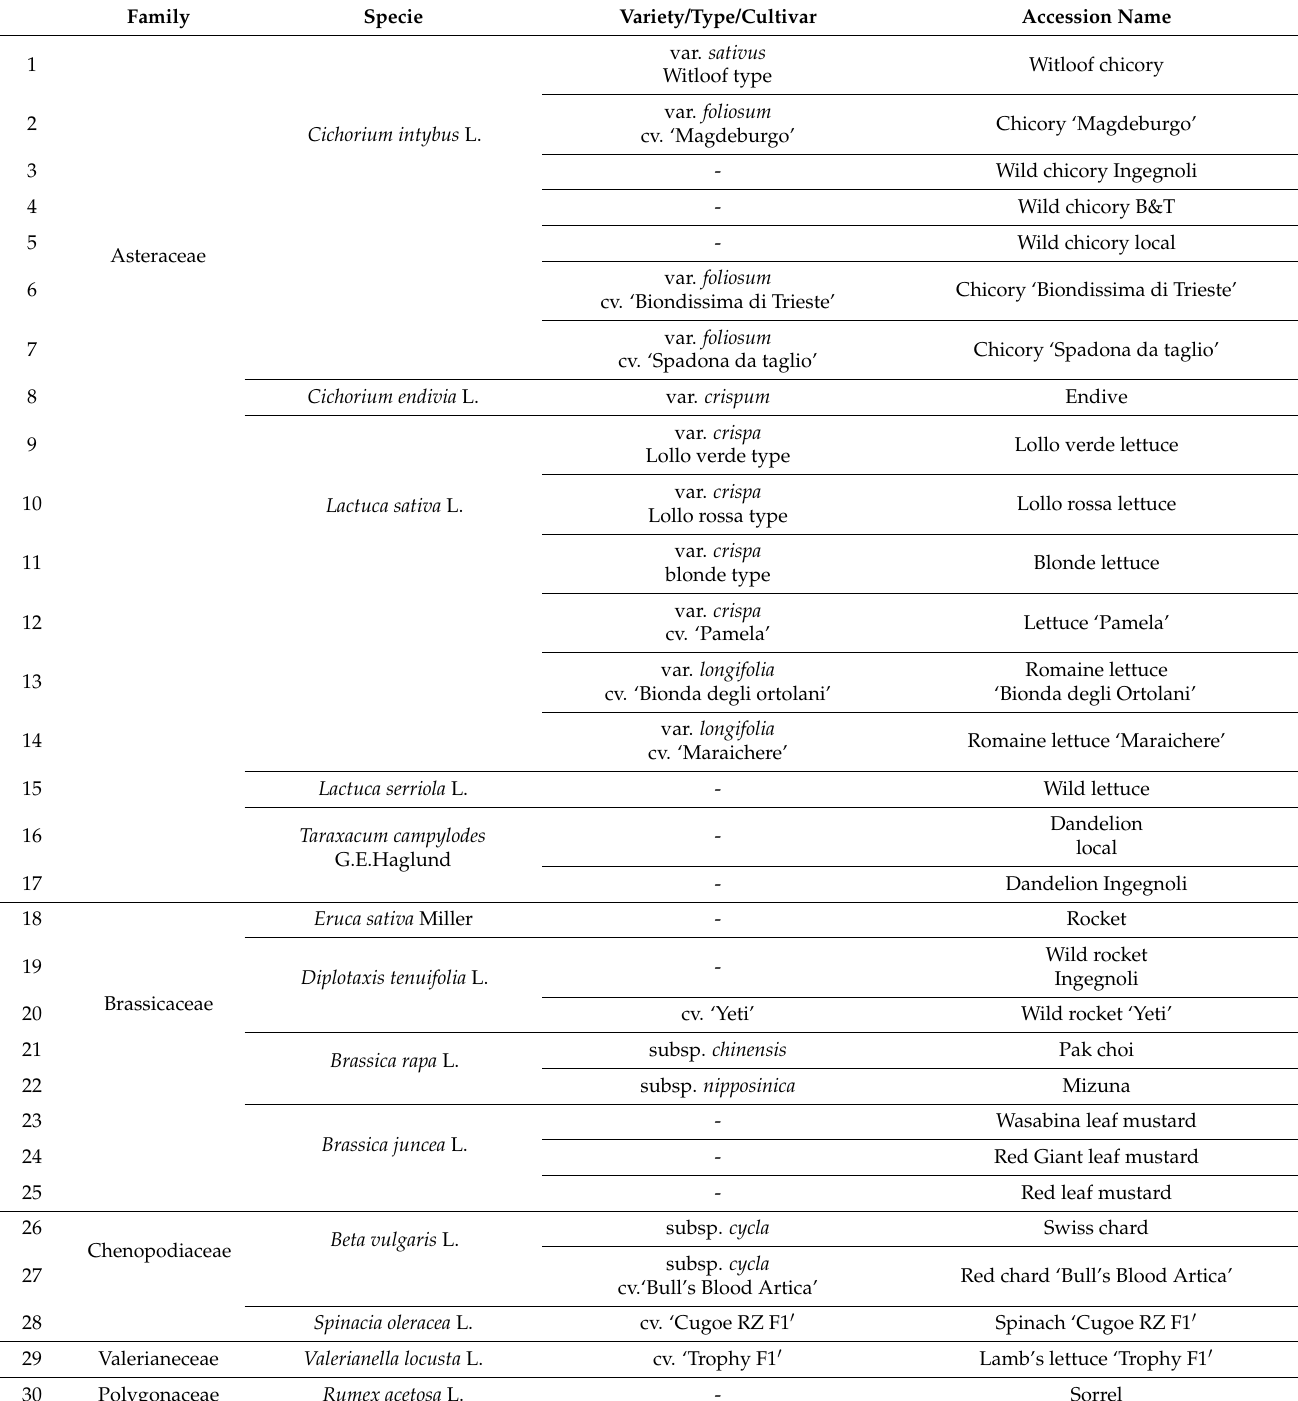
Table 1. Detailed list of the 30 baby leaf accessions used in the